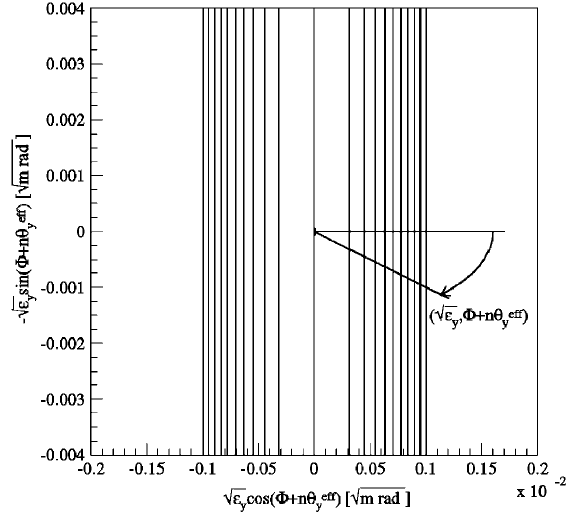
FIG. 4. Resonant invariant for the emittance-increasing reso- nance due to the toroid in the initial case where (cid:31) 10 (cid:3) 6 m rad and Q